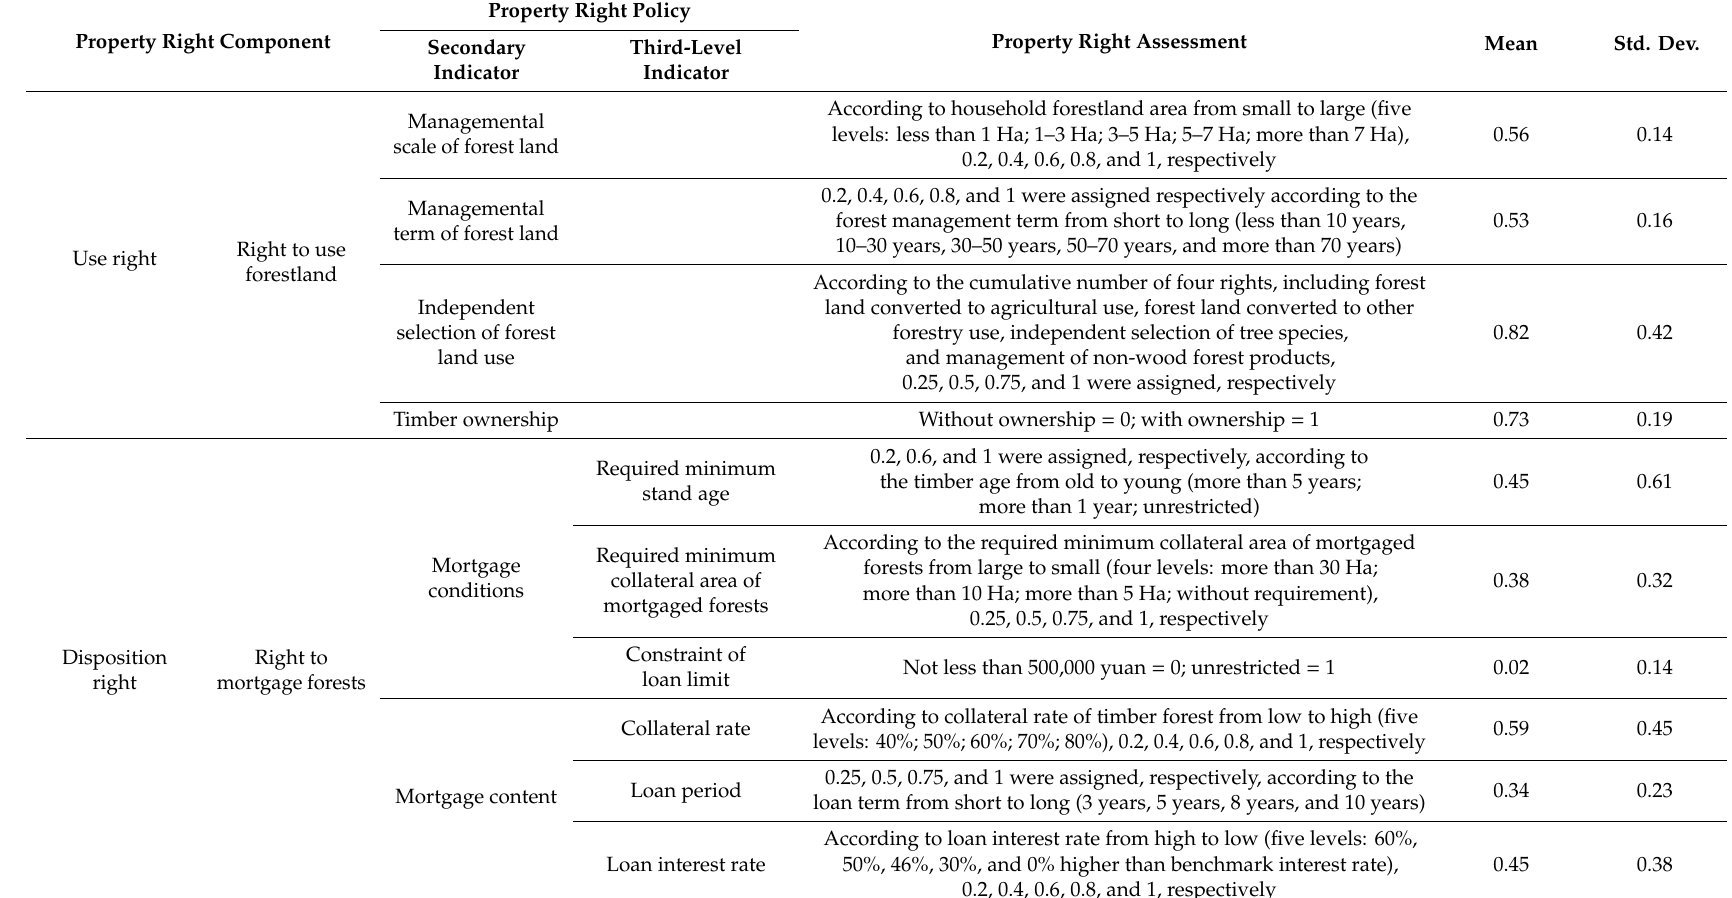
Table 1. Operationalization of variables in the measurement of forest property right integrity and its descriptive